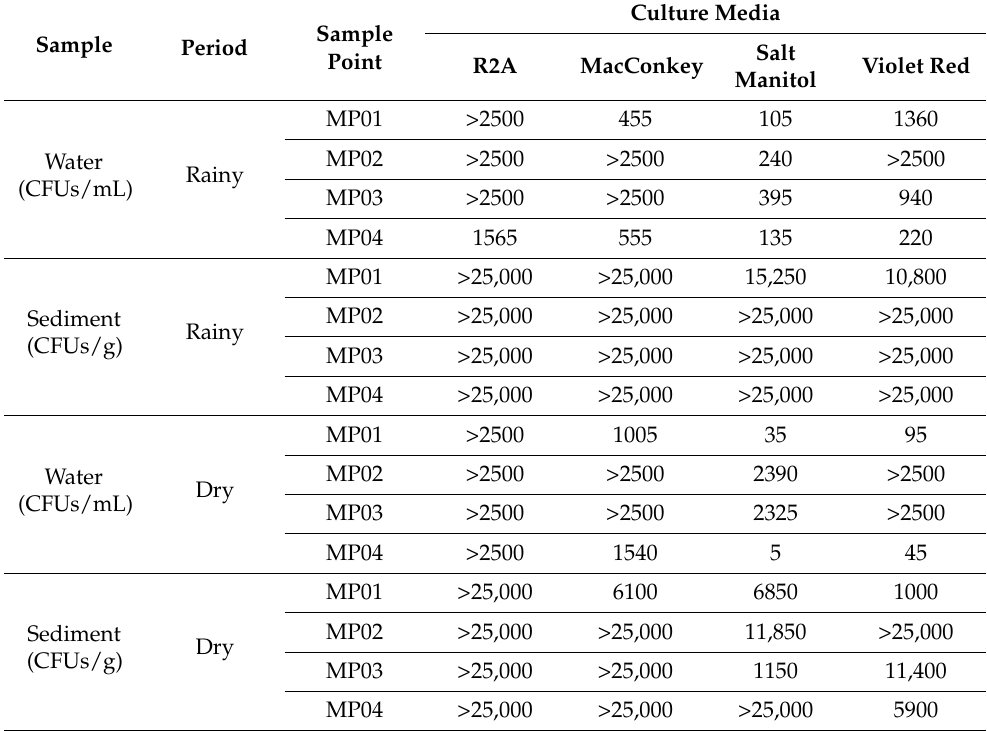
Table 2. Bacterial quantification of water and sediment samples from Meia Ponte River using the plate counting